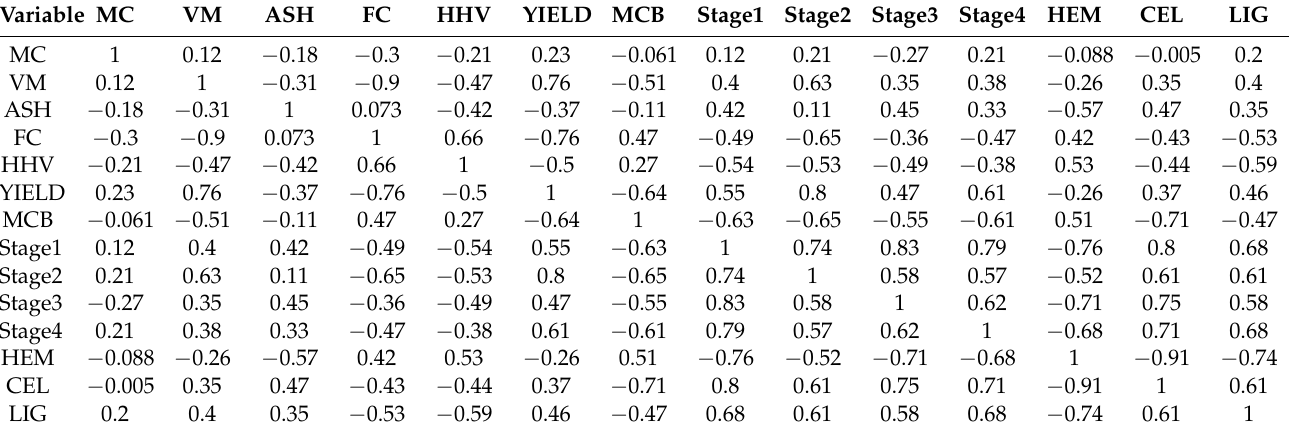
Table 12. Sperman correlation analysis of 14 variables representative of the carbonization process.